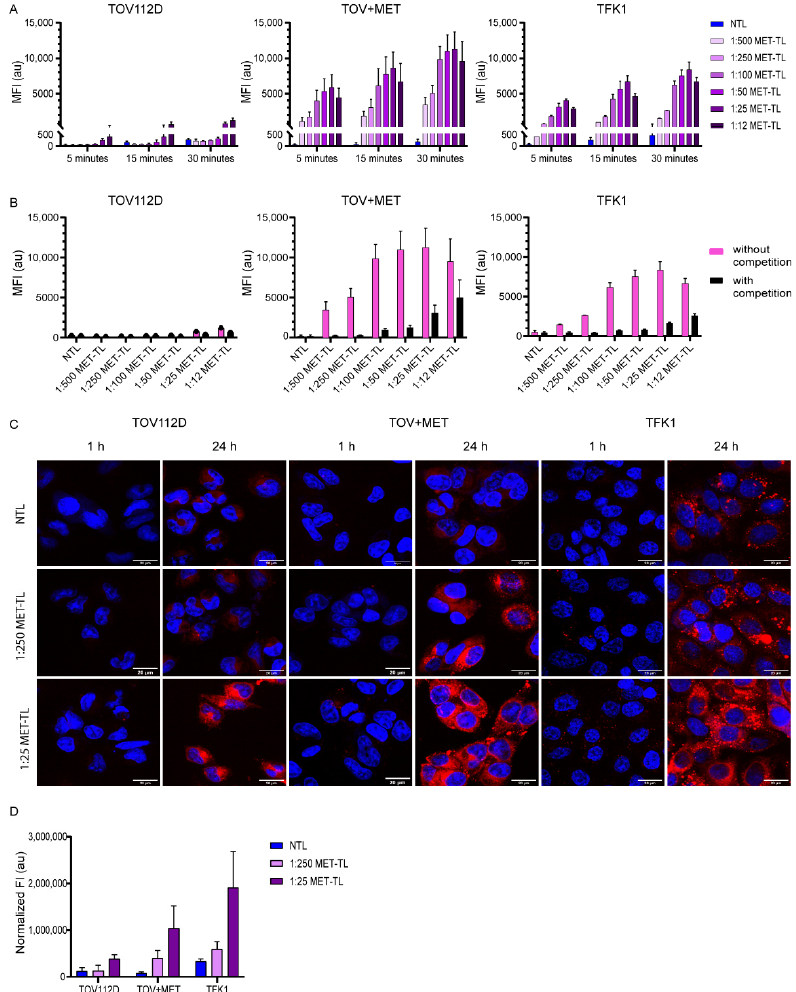
Figure 4. Association of MET-targeted liposomes (MET-TLs) with MET-expressing cells is mediated by the MET receptor and positively correlates with Nb density on the liposomal surface. ( A ) Cellular association with non-targeted liposomes (NTLs) and MET-TLs. TOV112D (-MET), TOV+MET, and TFK1 (+MET) cells were incubated with a dispersion of 60 µM of fluorescently labeled liposomes for 5, 15, and 30 min under standard culture conditions. ( B ) Specific association of MET-TLs with MET receptor. Cells were pre-incubated with a solution containing 1 µM of MET-Nbs for 15 min, followed by incubation with NTLs or MET-TLs. Liposome association in A and B was measured with flow cytometry and plotted as mean fluorescent intensity (MFI). Data were normalized to the mean of the control group (non-treated cells) and expressed as mean ± SD of two independent experiments (performed in duplicate). ( C ) Confocal microscopy of TOV112D, TOV+MET, and TFK1 cells incubated with a dispersion of 500 µM of fluorescently labeled liposomes for 1 and 24 h under standard culture conditions. Nuclei were stained with Hoechst 33342 (blue). Lipids labeled with Cy5.5 appear in red. Scale bar represents 20 µm. The confocal images clearly demonstrate uptake of the liposomes. ( D ) Quantification of the fluorescence intensity of NTLs and MET-TLs taken up by cells after 24 h incubation (based on confocal microscopy data).